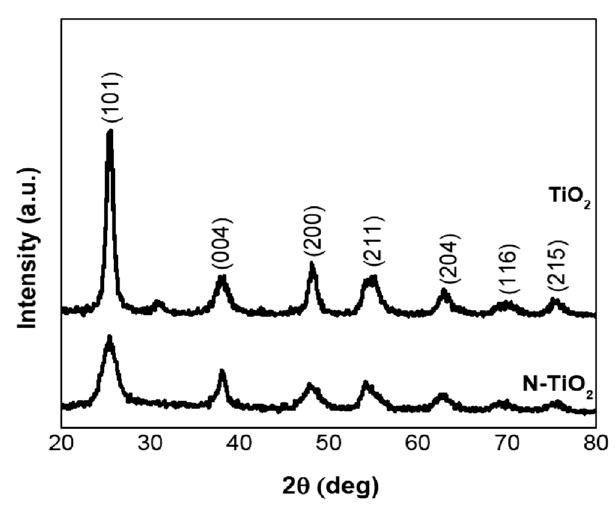
Figure 2. X-ray diffraction (XRD) patterns of TiO 2 and N-TiO 2 .